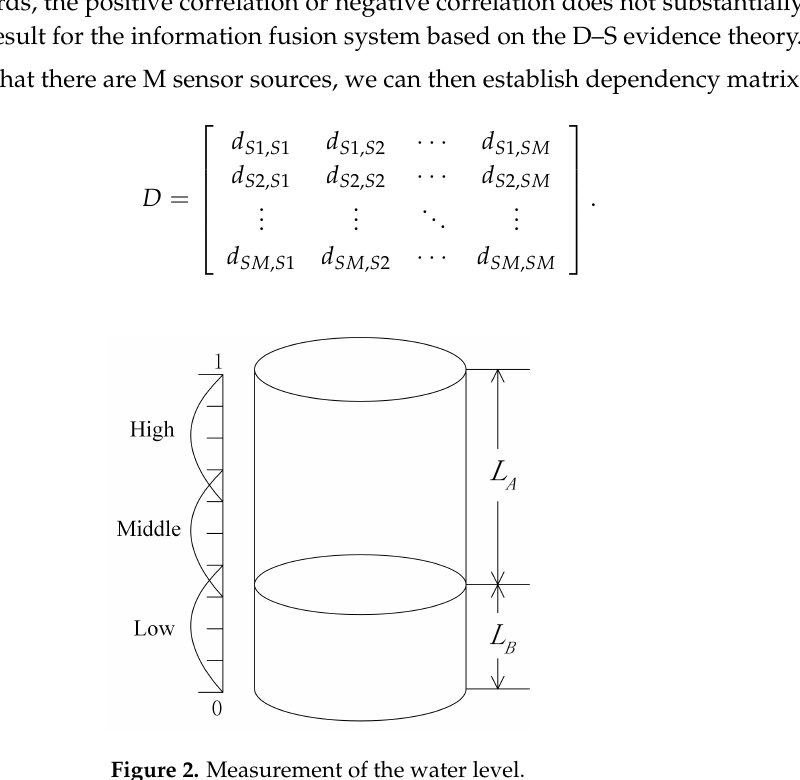
Figure 2. Measurement of the water